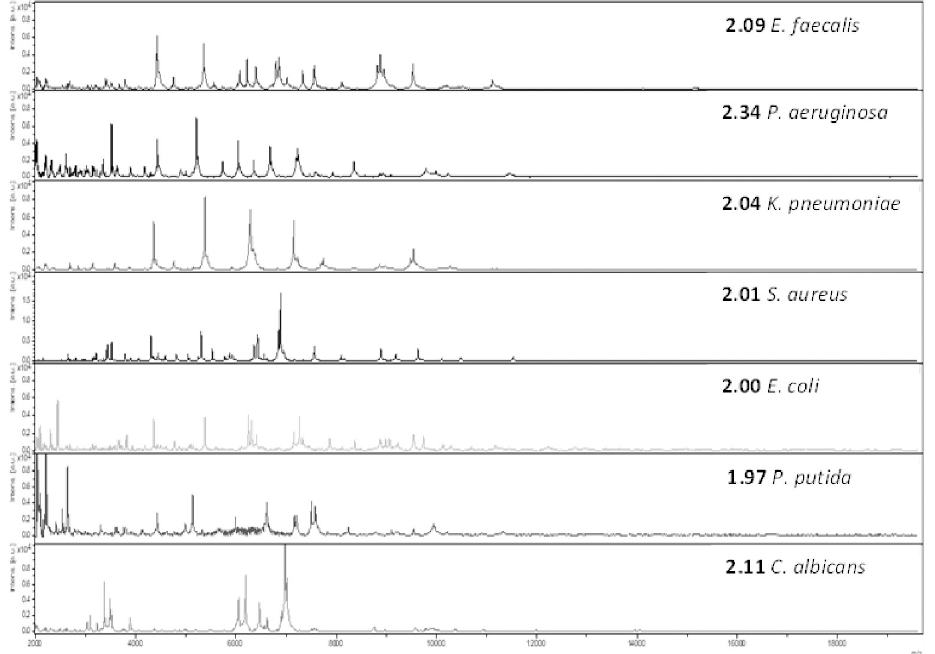
Fig 4. MALDI-TOF MS spectra of bacteria and yeast captured and eluted from FcMBL-processed beads. Bruker Biotyper log scores in bold.